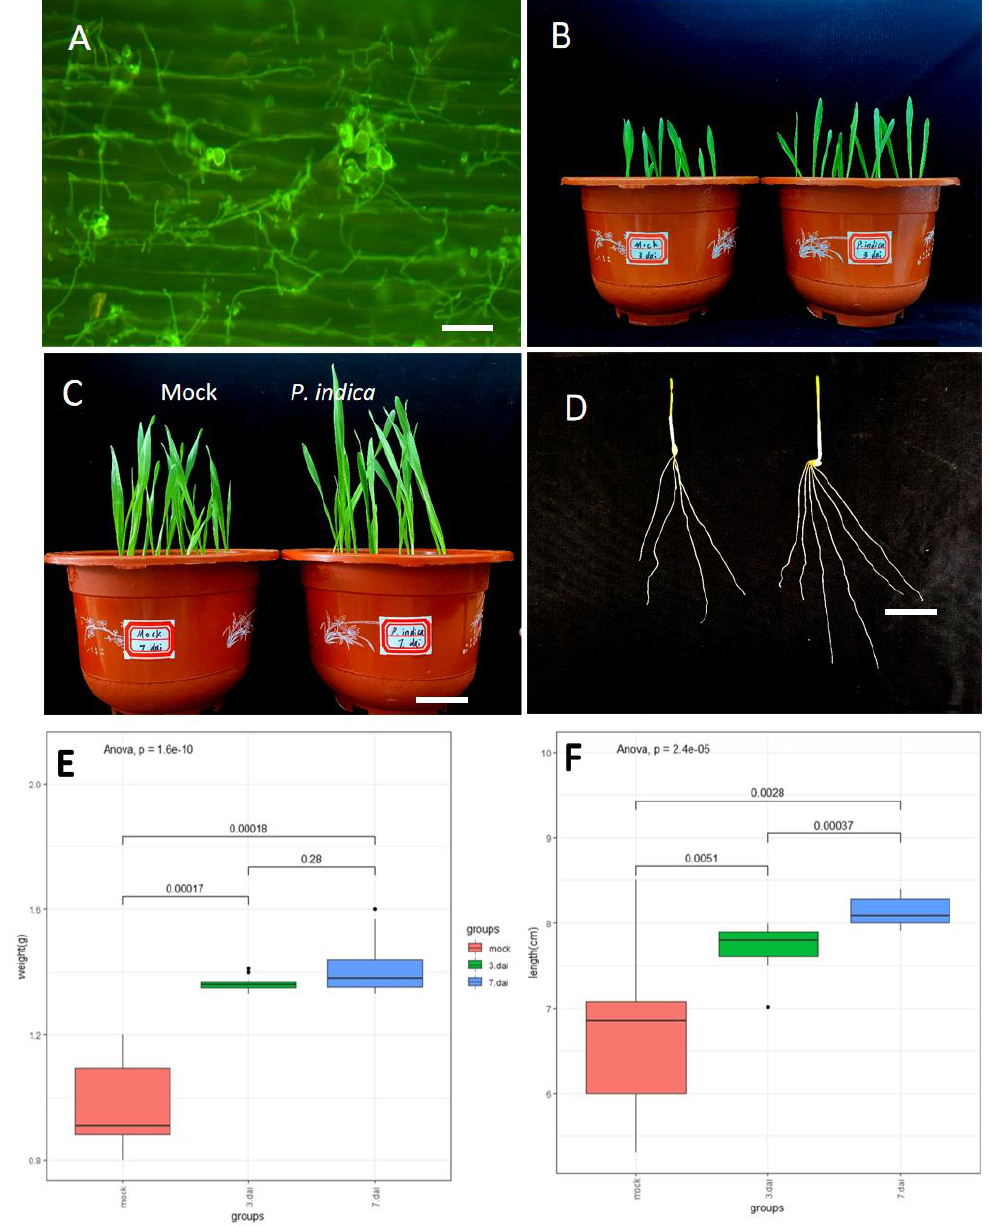
Figure 1. Root colonization by P. indica increases the growth and yield of barley. ( A ) Colonization pattern of P. indica on barley roots. Fluorescence microscopy showing WGA-AF488 staining of P. indica cell walls (λexc494 nm, λem515). ( B , C ) Total grain biomass of control vs. colonized plants at 3 dai and 7 dai. ( D ) Root branching between control and colonized roots at 3 dai. For b and c, barely seeds were seed soaking with 5 × 10 5 chlamydospores per ml and grown in soil. ( E ) Shoot length of 3 dai vs. mock and 7 dai vs. mock. ( F ) weight of the seedlings from 3 dai vs. mock and 7 dai vs. mock Sample size n = 10. The results are from three independent biological replicates. The significance threshold for p values, corrected for multiple testing (Benjamini–Hochberg) was set at